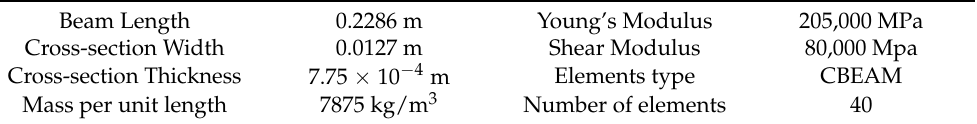
Table 7. Straight beam